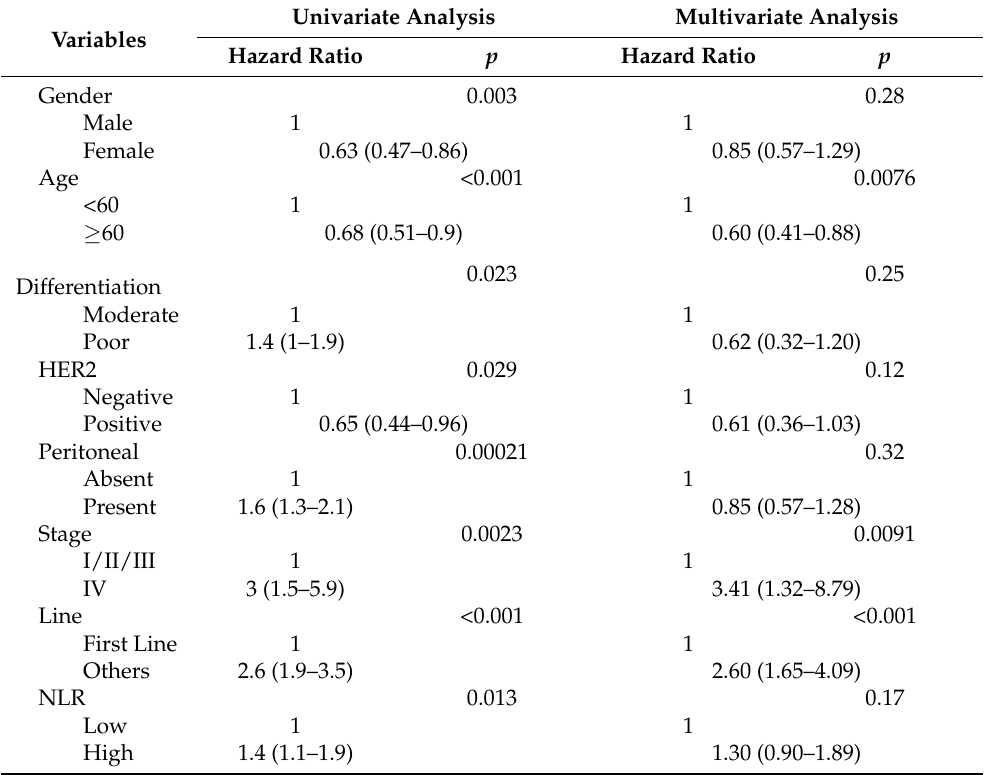
Table 3. Multivariate analysis of NLR for